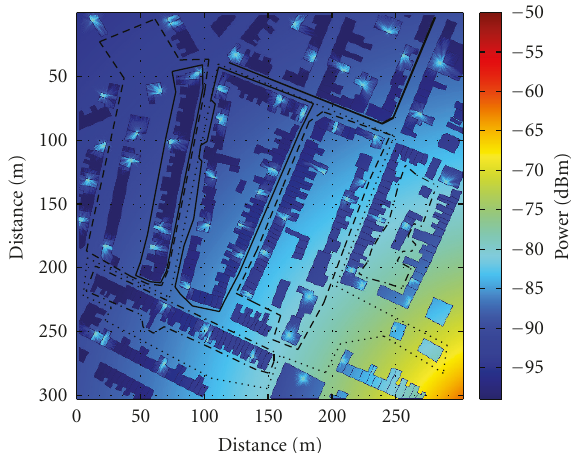
Figure 3: Received power per OFDMA subcarrier (OFDMA- 512 system) in a residential area covered by 1 macrocell and 64 femtocells. Each femtocell premises contains several indoor users, while 8 pedestrian users are located outdoors, being their routes also